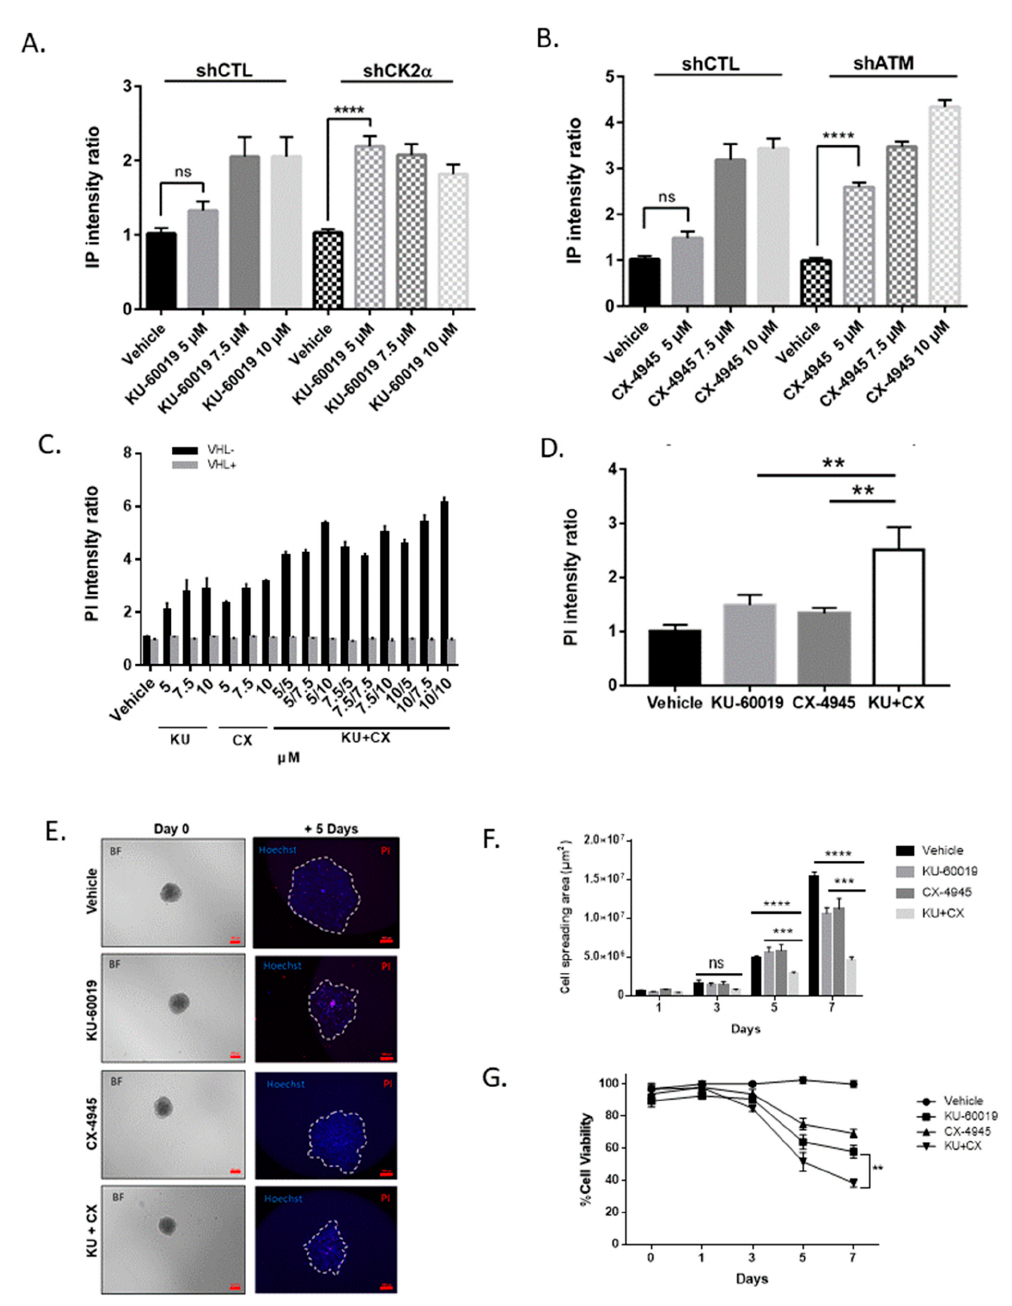
Figure 2. Cell death is induced in tumor environment conditions. ( A , B ) Multi cellular tumor spheroids (MCTS) were pre-formed for 3 days with indicated 786-O sh-transduced cell lines before treatment for 48 h with vehicle or increasing concentrations of KU-60019 or CX-4945 (5, 7.5 and 10 µ M). Cell death was monitored by PI quantification using